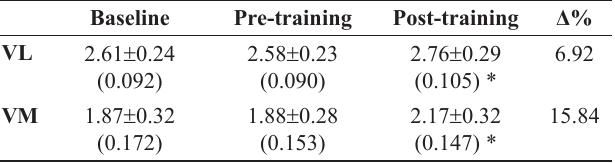
1. Muscle thickness values [in cm; mean ± standard deviation (coefficient of variation)] from vastus lateralis (VL) and vastus me- dialis (VM) during the control period and after the 12-week isokinetic eccentric training period.